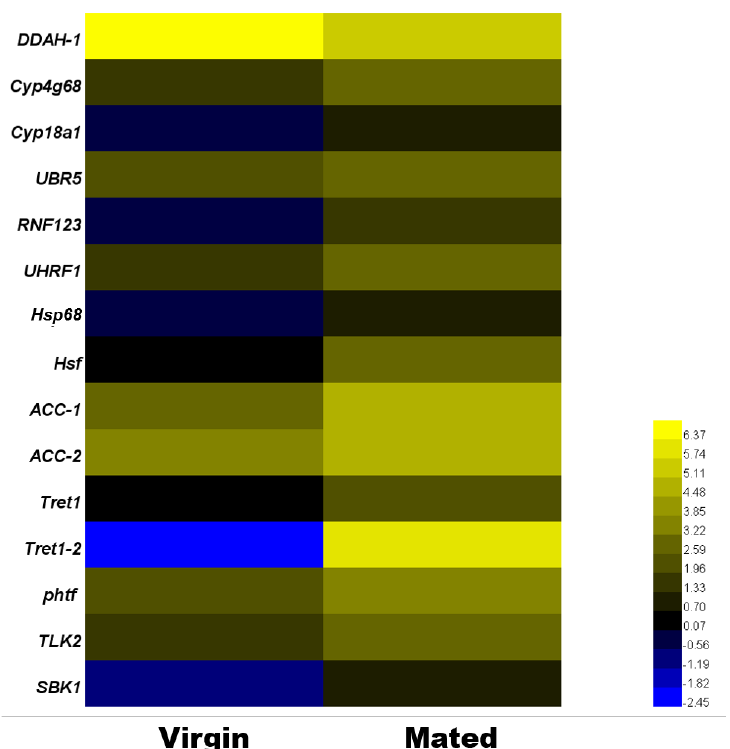
Figure 3. Expression profile of transcripts that are differentially expressed between mated and virgin B. tabaci females by RNA-seq. The heatmap shows the transcriptome data of the selected genes, which are based on the log2(fragments per kb of transcript per million fragments mapped (FPKM)) of genes in virgin and mated females. The color scale represents the median-centered log2(FPKM ).